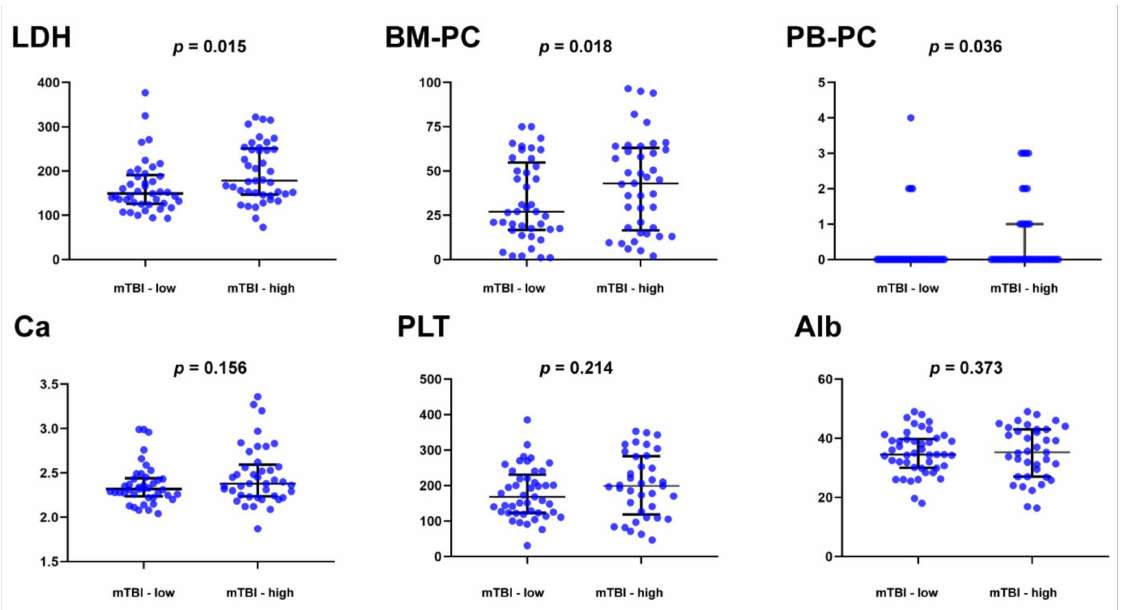
Figure 5. Clinical correlation of the molecular tumor burden index (mTBI) AND clinical parameters in 82 multiple myeloma patients. The patients were divided into mTBI-hi and mTBI-lo groups based on the median value. Compared to the MM patients in mTBI-lo group, those in mTBI-hi group had higher concentrations of serum lactate dehydrogenase (LDH) and higher percentages of bone plasma cells (BM-PC) and peripheral blood circulating plasma cells